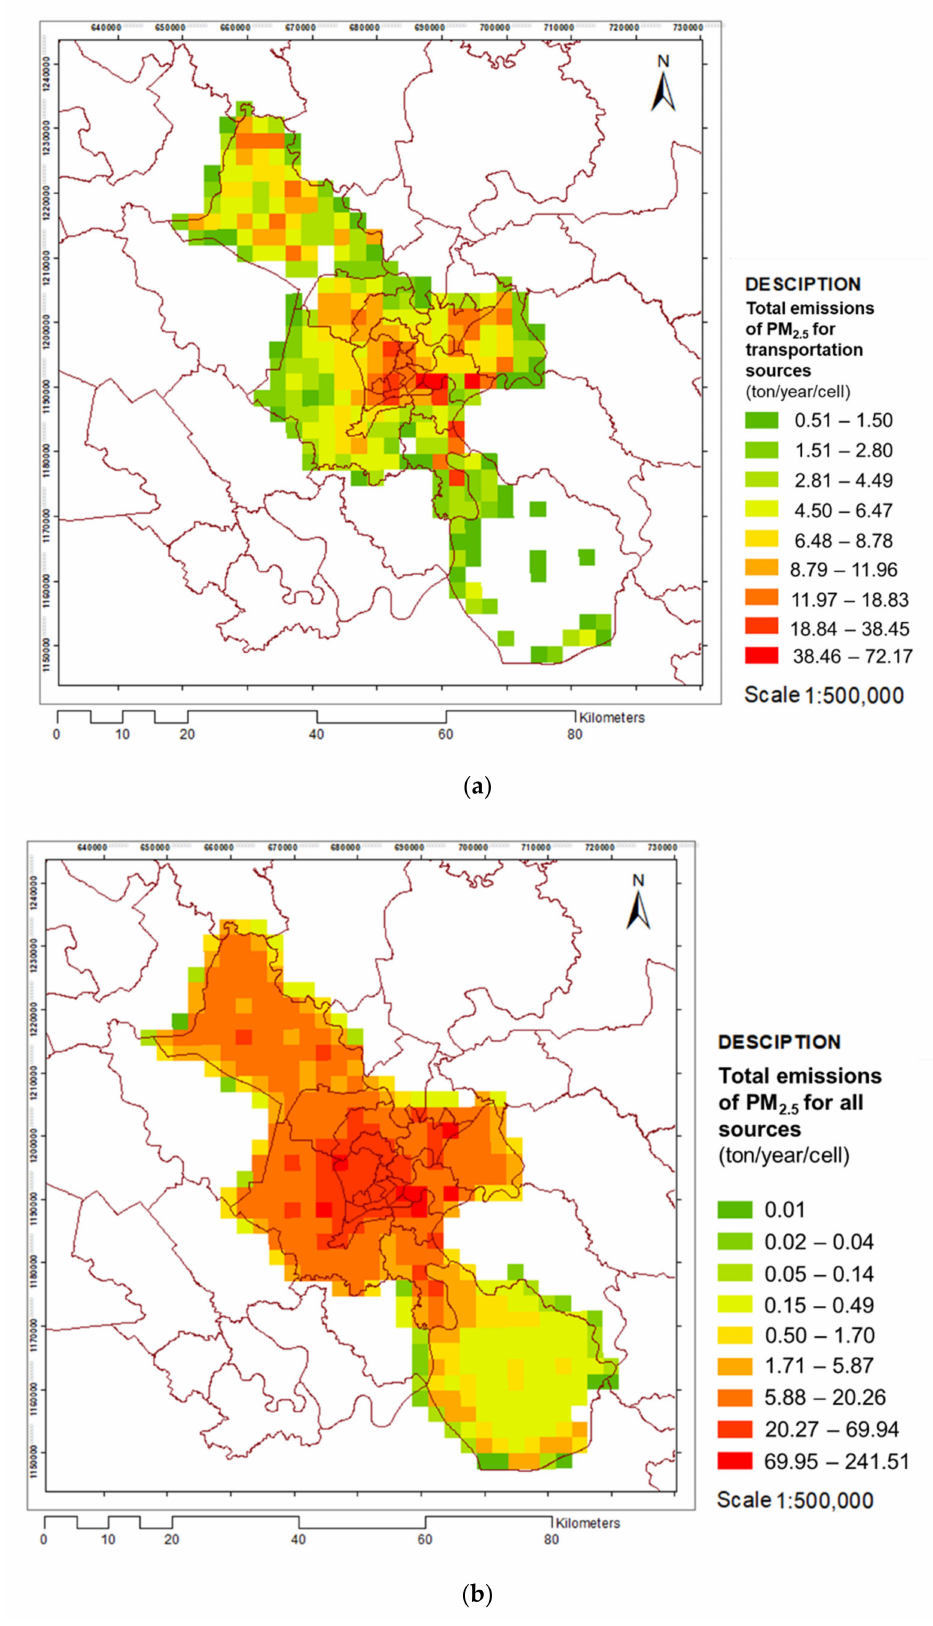
Figure 4. Spatial distribution of PM 2.5 emissions for transportation sources ( a ); PM 2.5 emissions distribution for all sources ( b ) in